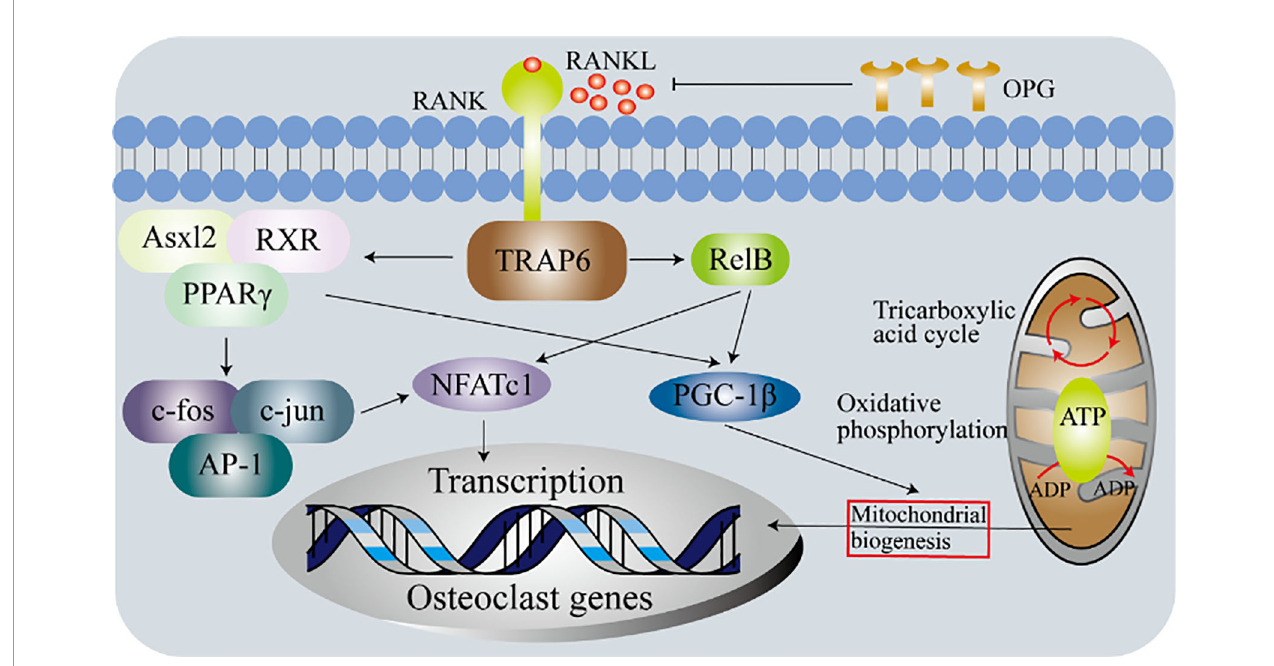
FIGURE 5 | Metabolic determinants of the differentiation osteoclasts. Experiments with primary bone marrow macrophages in Relb or Asxl2-de fi cient mice show that PGC-1 b plays a vital role in the mitochondrial biogenesis of osteoclasts. However, in addition to initiating the expression of osteoclasts genes, c-fos-mediated activation of NFATc1 is also required. These indicate that although mitochondrial biogenesis and osteoclasts differentiation are independent processes, both require the production of functional